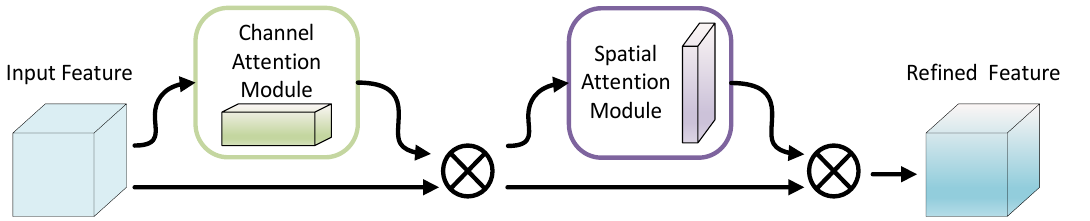
Figure 3. An overview of Convolutional Block Attention Module (CBAM). The module has two sequential sub-modules: channel and spatial attention modules.